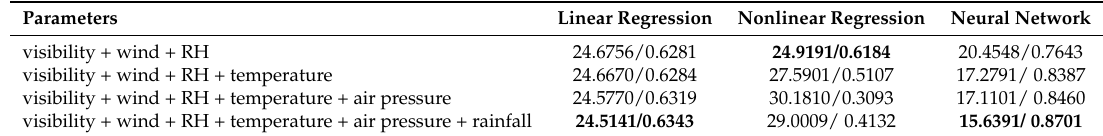
Table 3. Effect of using different meteorological parameter inputs on the averaged RMSE ( µ g/m 3 ) and correlation coefficients of three machine learning model